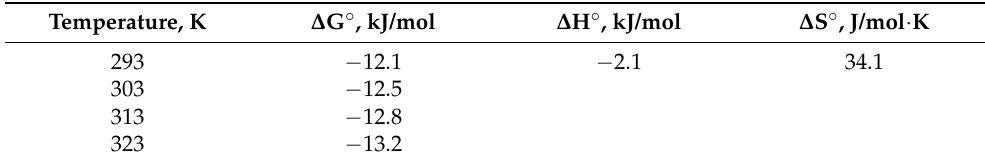
Table 3. Thermodynamics parameters for Y(III) sorption on A. platensis . Temperature, K ∆ G ◦ ,